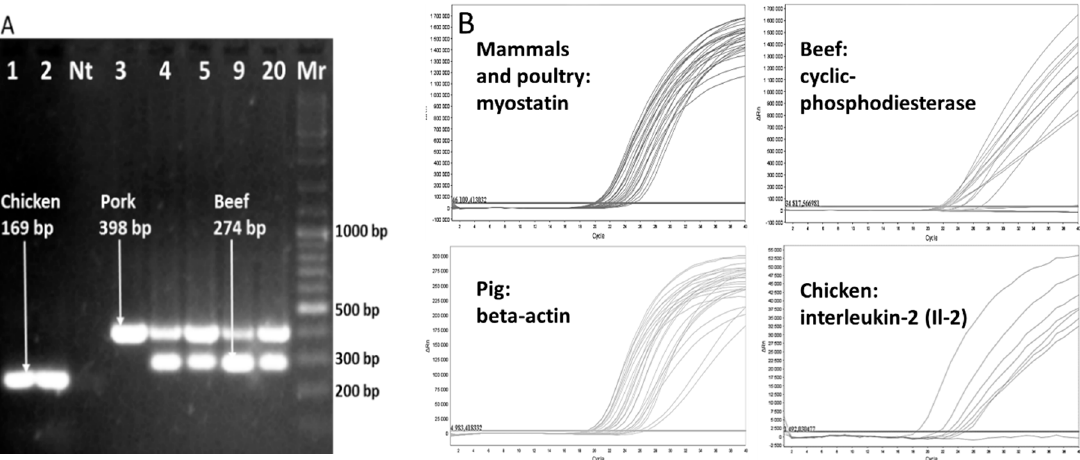
Figure 6. Examples of DNA analysis. Electropherogram of ( A ) mPCR amplicons and ( B ) fluorescent curves of mqPCR. Nt—no template control; x-axis—number of PCR cycles; y-axis—delta Rn (fluorescence).